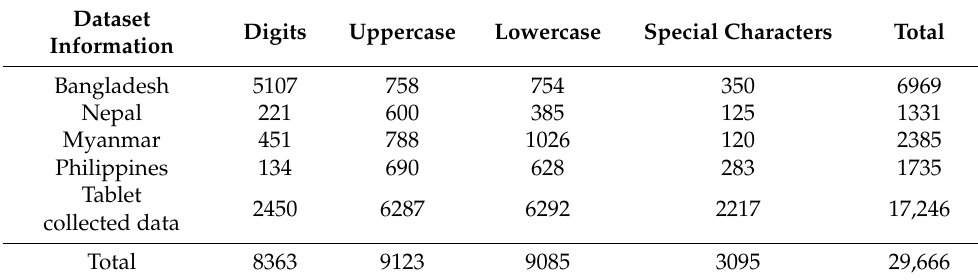
Figure 13. Sample rough data from students in: ( a ) Nepal using the traditional way, ( b ) Myanmar using the traditional way, ( c ) Philippines using the traditional way, ( d ) Bangladesh using the traditional way, and ( e ) Myanmar using an Android tablet. Table 1. Dataset information.